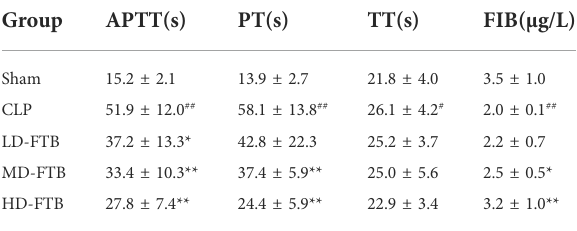
TABLE 2 Changes in APTT, PT, TT and FIB levels after FTB